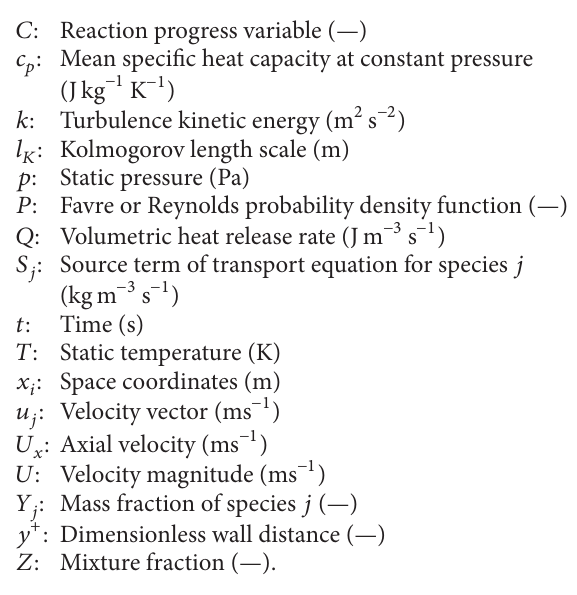
Figure 14: Predicted time-averaged isolines of the mixture fraction with respect to the time-averaged flame front ( ̃𝑍 flame and (b) SG-FGR0 flame (the premixed values are 0.025 and 0.065 for NG-FGR0 and SG-FGR0 flames, resp.). Table 4: Combustor exit CO and NO mass fractions for SG-FGR0. Measured Predicted CO ppm @ 15% O 2 1.04 1.74 NO ppm @ 15% O 2